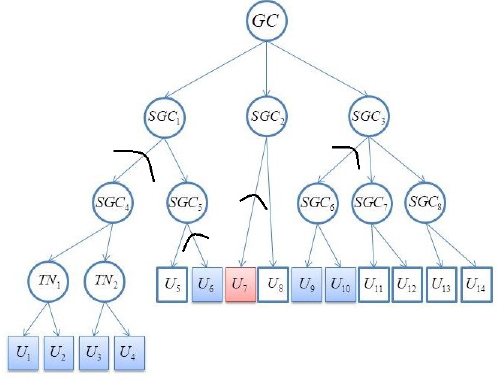
Figure 6. The key tree of a dynamic